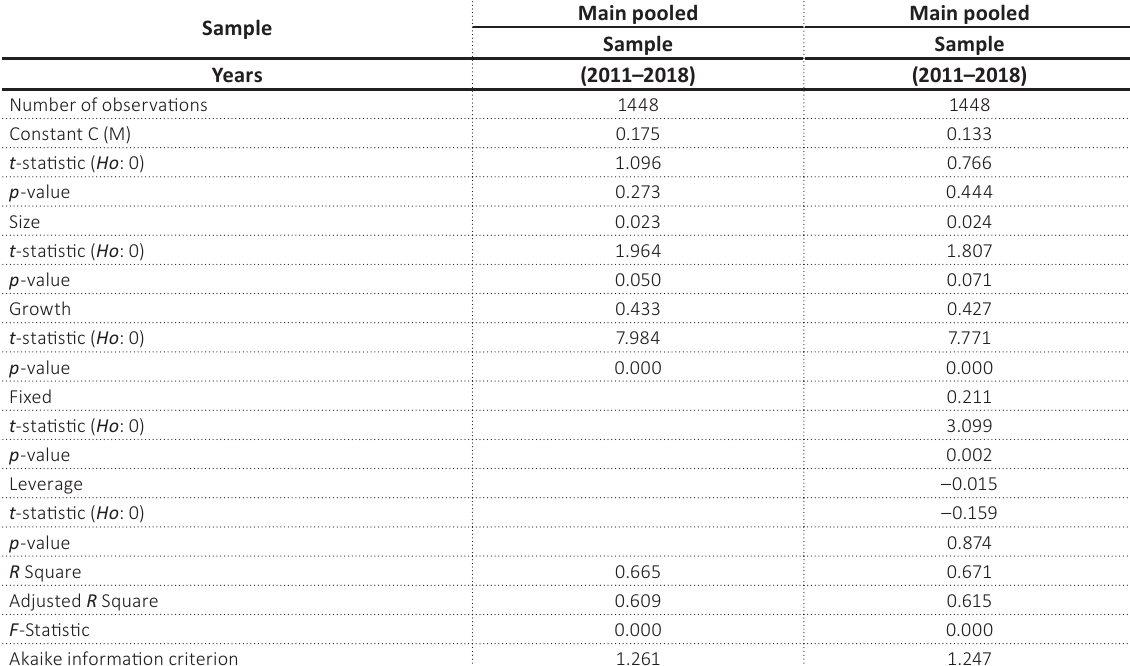
Table 10. Determinants of firms’ profitability: pooled data using market